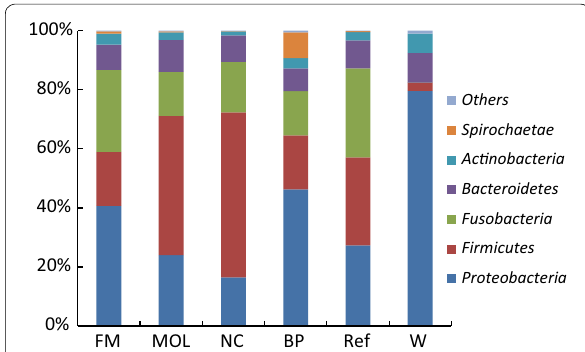
Fig. 2 The intestinal bacteria communities at phyla level. The color‑ coded bar plot showed the percentages of intestinal bacteria com‑ munities in W, Ref, BP, NC, MOL and FM groups at phyla level. “Others” meant the relative abundance were less than 1%